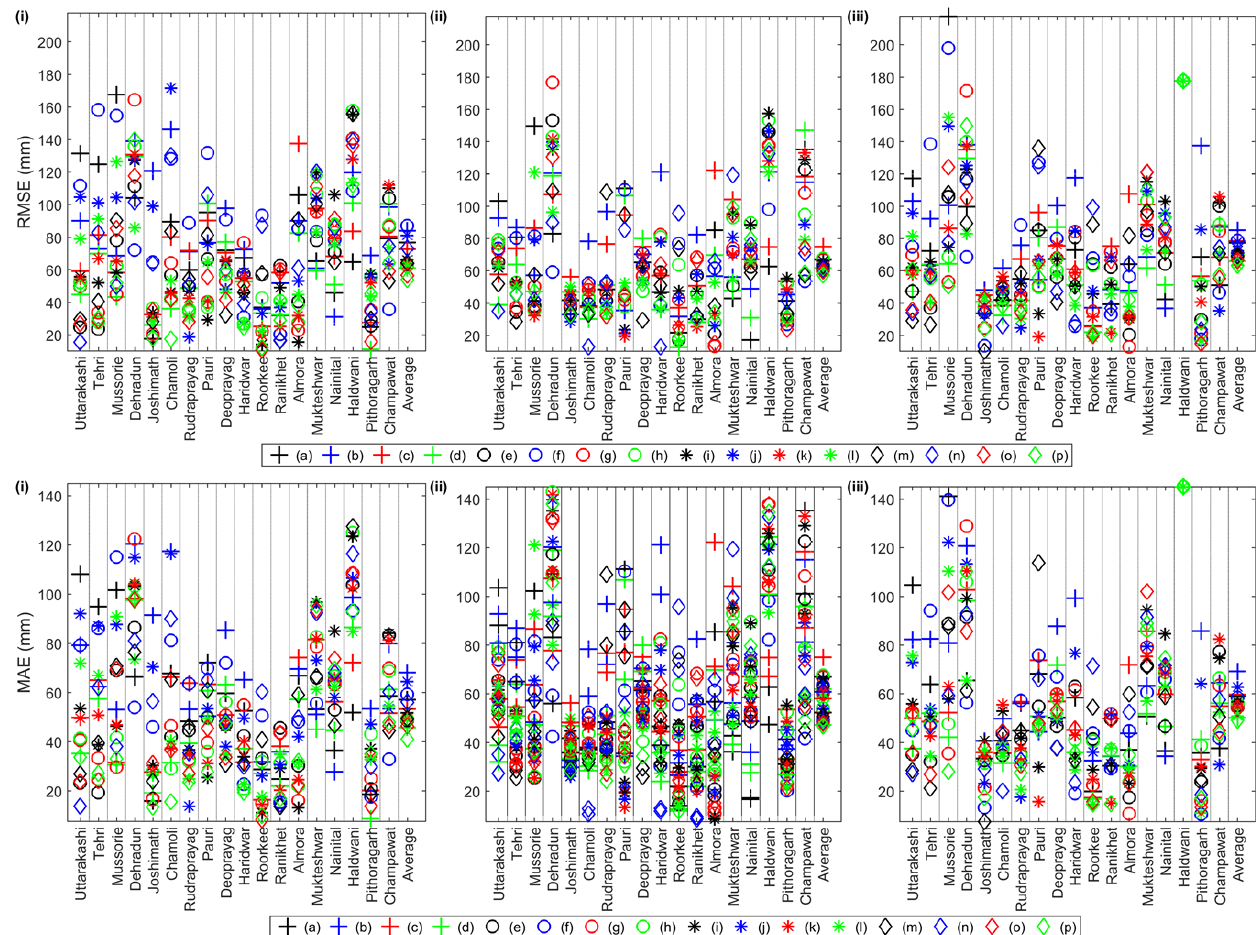
Figure 7. Root mean square error (top panels) and mean absolute error (bottom panels) computed temporally for (i) Domain 1, (ii) Domain 2a and (iii) Domain 2b for WRF configurations (a) to (p). Refer to Appendix A (Table A1) for the detailed list of the WRF configurations.